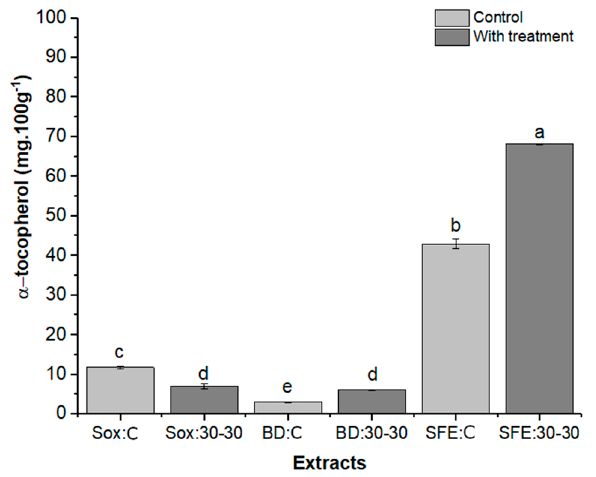
Figure 7. Chromatogram of α -tocopherol standard solution (12.5 mg/L) ( A ) SFE grape seed oil: 30-30 ( B ) obtained by HPLC-DAD at 292 nm.